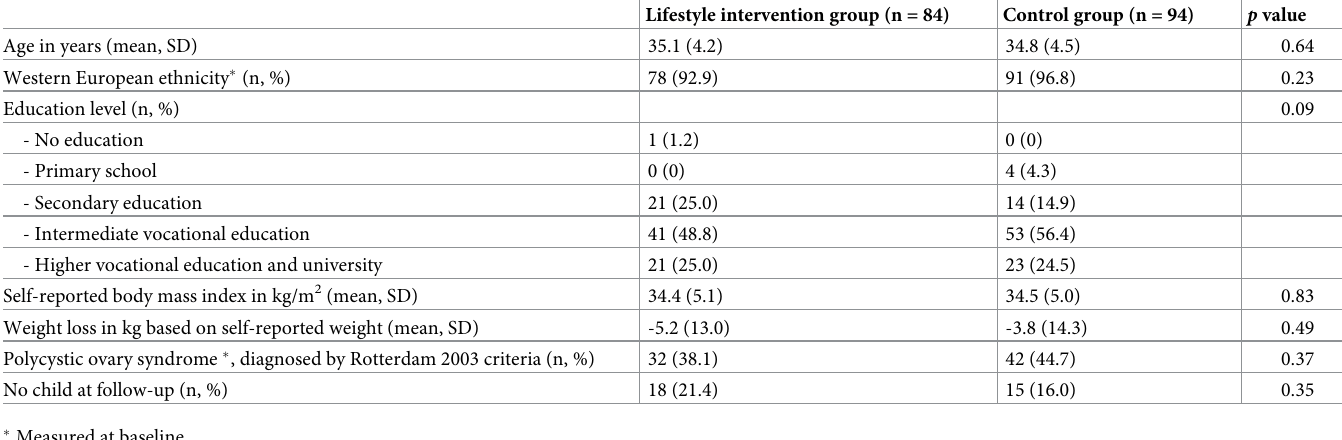
Table 2. Participant characteristics at